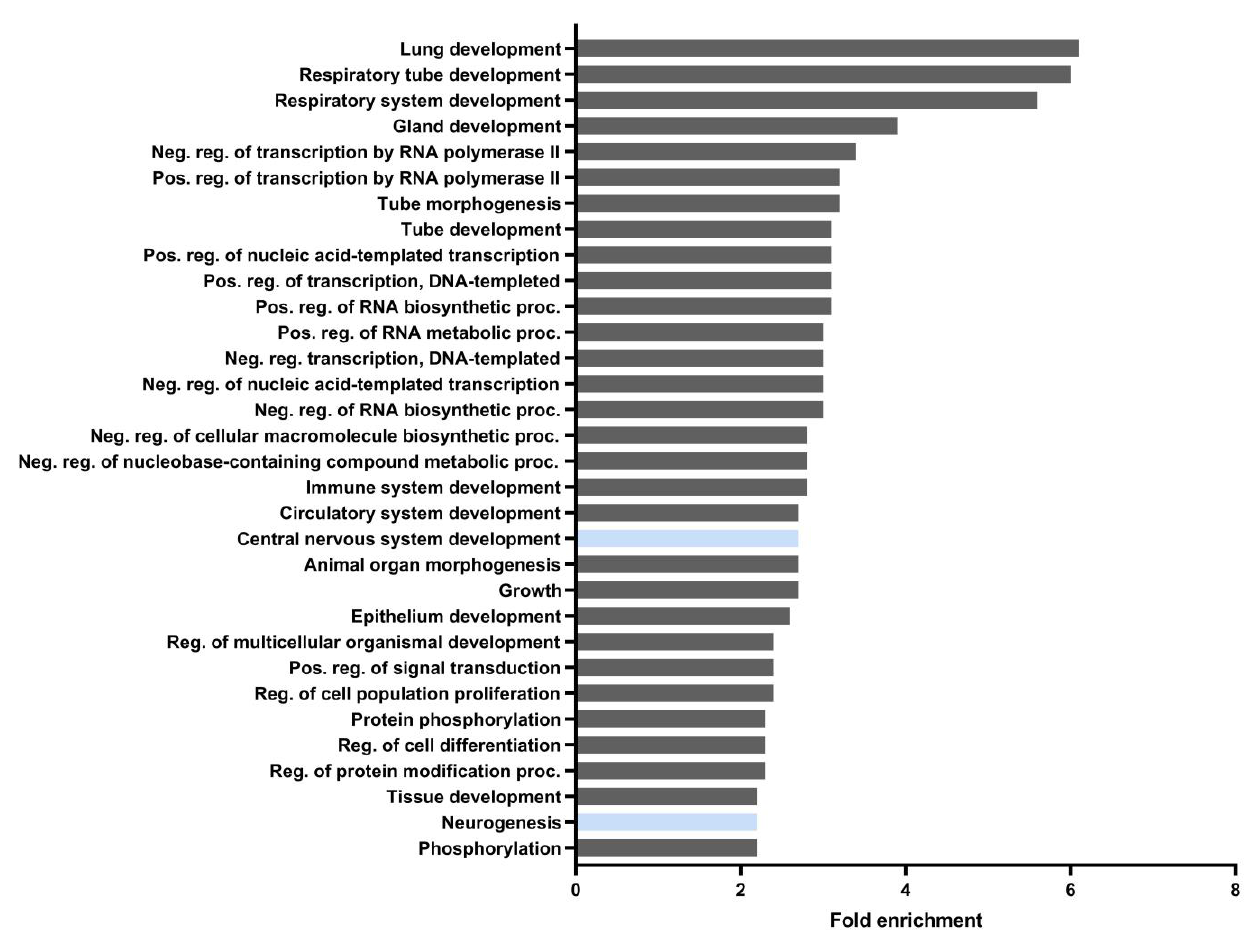
Figure 6. GO biological process analysis using the ShinyGo 0.76.2 platform. Neuronal-related functions are highlighted (blue). Using the TargetScan platform, the list of genes that can be modulated by miR-155-5p was extracted. These genes were analyzed using the ShinyGO 0.76.2 pathway database GO biological process platform.